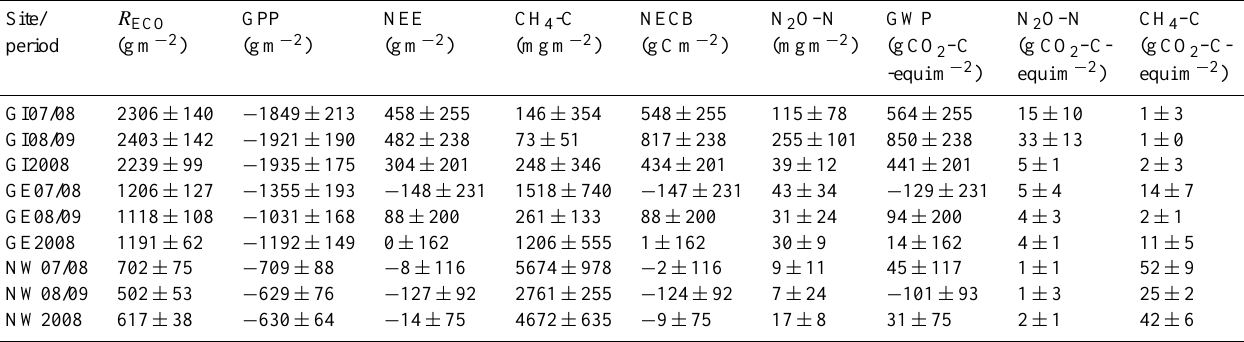
Table 2. Annual components (ecosystem respiration R ECO , gross primary production GPP, net ecosystem exchange NEE and CH 4 –C ex- change) of the net ecosystem carbon balance (NECB) at the intensively used grassland (GI), extensively used grassland (GE) and the natural wetland (NW) site in different measuring periods (07/08, 08/09 and 2008 denotes 1 July 2007–30 June 2008, 1 July 2008 to 30 June 2009, and the calendar year 2008, respectively). Additionally, annual N 2 O–N exchange is displayed. GWP is summed up considering NEE, manuring, cutting, CH 4 –C and N 2 O–N exchange. 2007 IPCC standards (Forster et al., 2007) were used with a radiative forcing factor of 25 for CH 4 and 298 for N 2 O related to CO 2 and a time horizon of 100yr; values were converted into atomic mass of CO 2 –C, CH 4 –C and N 2 O–N. The total contribution of N 2 O–N and CH 4 –C to GWP in g CO 2 –C equivalents m − 2 is shown in the last two columns. Note that small differences from the NEE sum are due to rounding; for clarity the units for CH 4 –C and N 2 O–N are given in mgm − 2 compared to the others. Errors are displayed as explained in Sect.